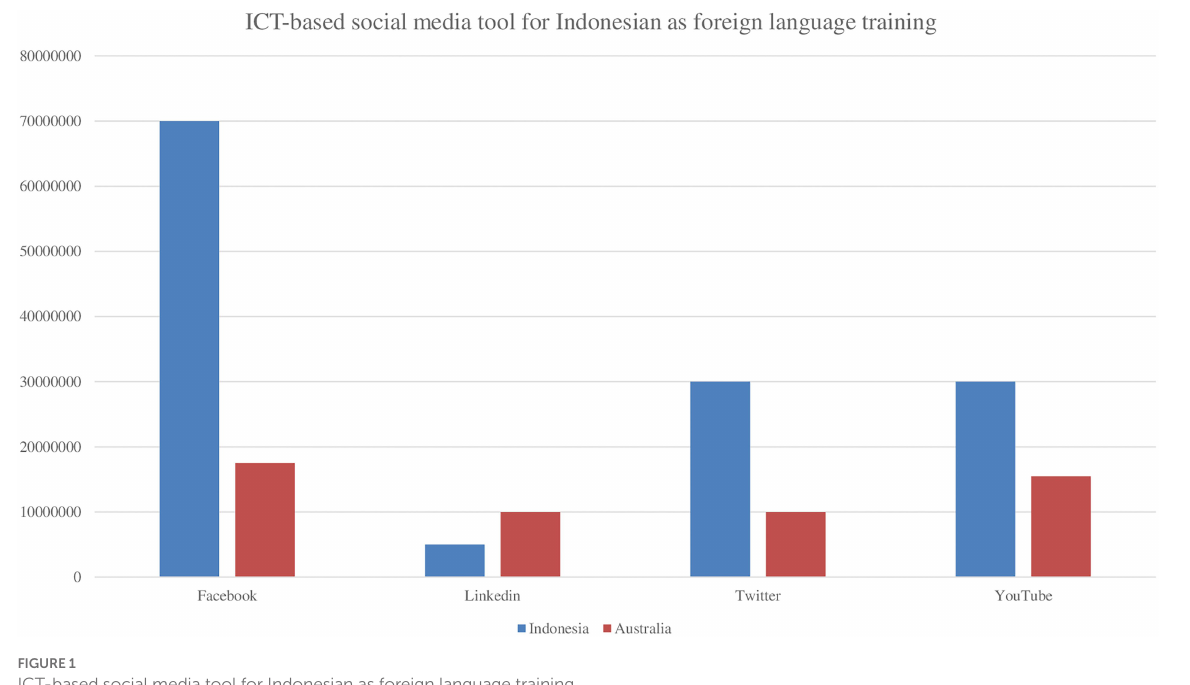
FIGURE 1 ICT-based social media tool for Indonesian as foreign language